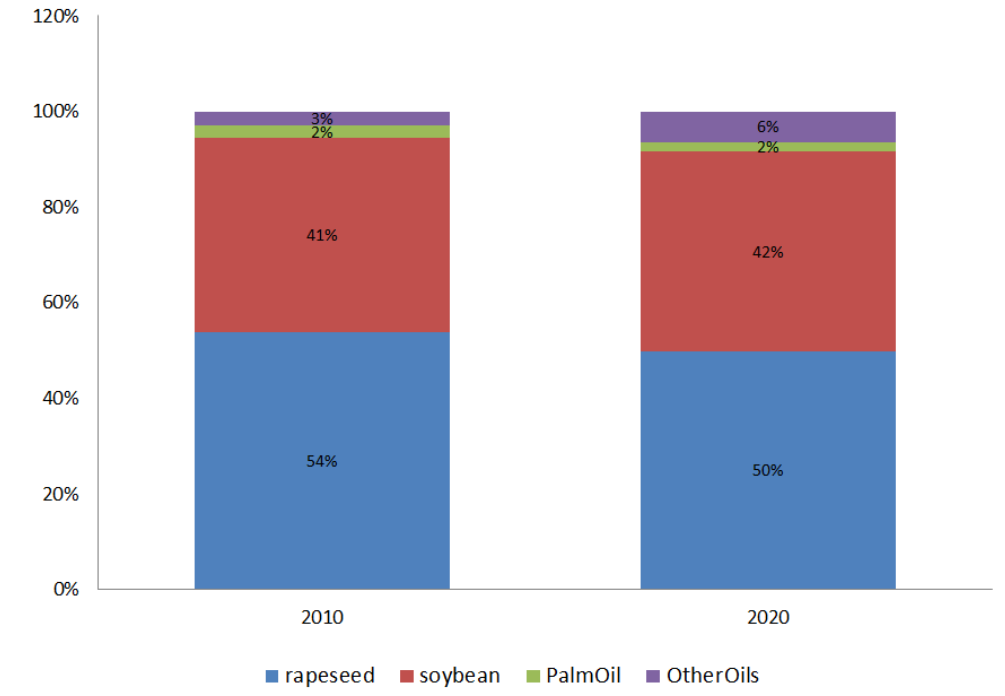
Figure 7. Share of total feedstock tonnage used in global biodiesel production from various sources.